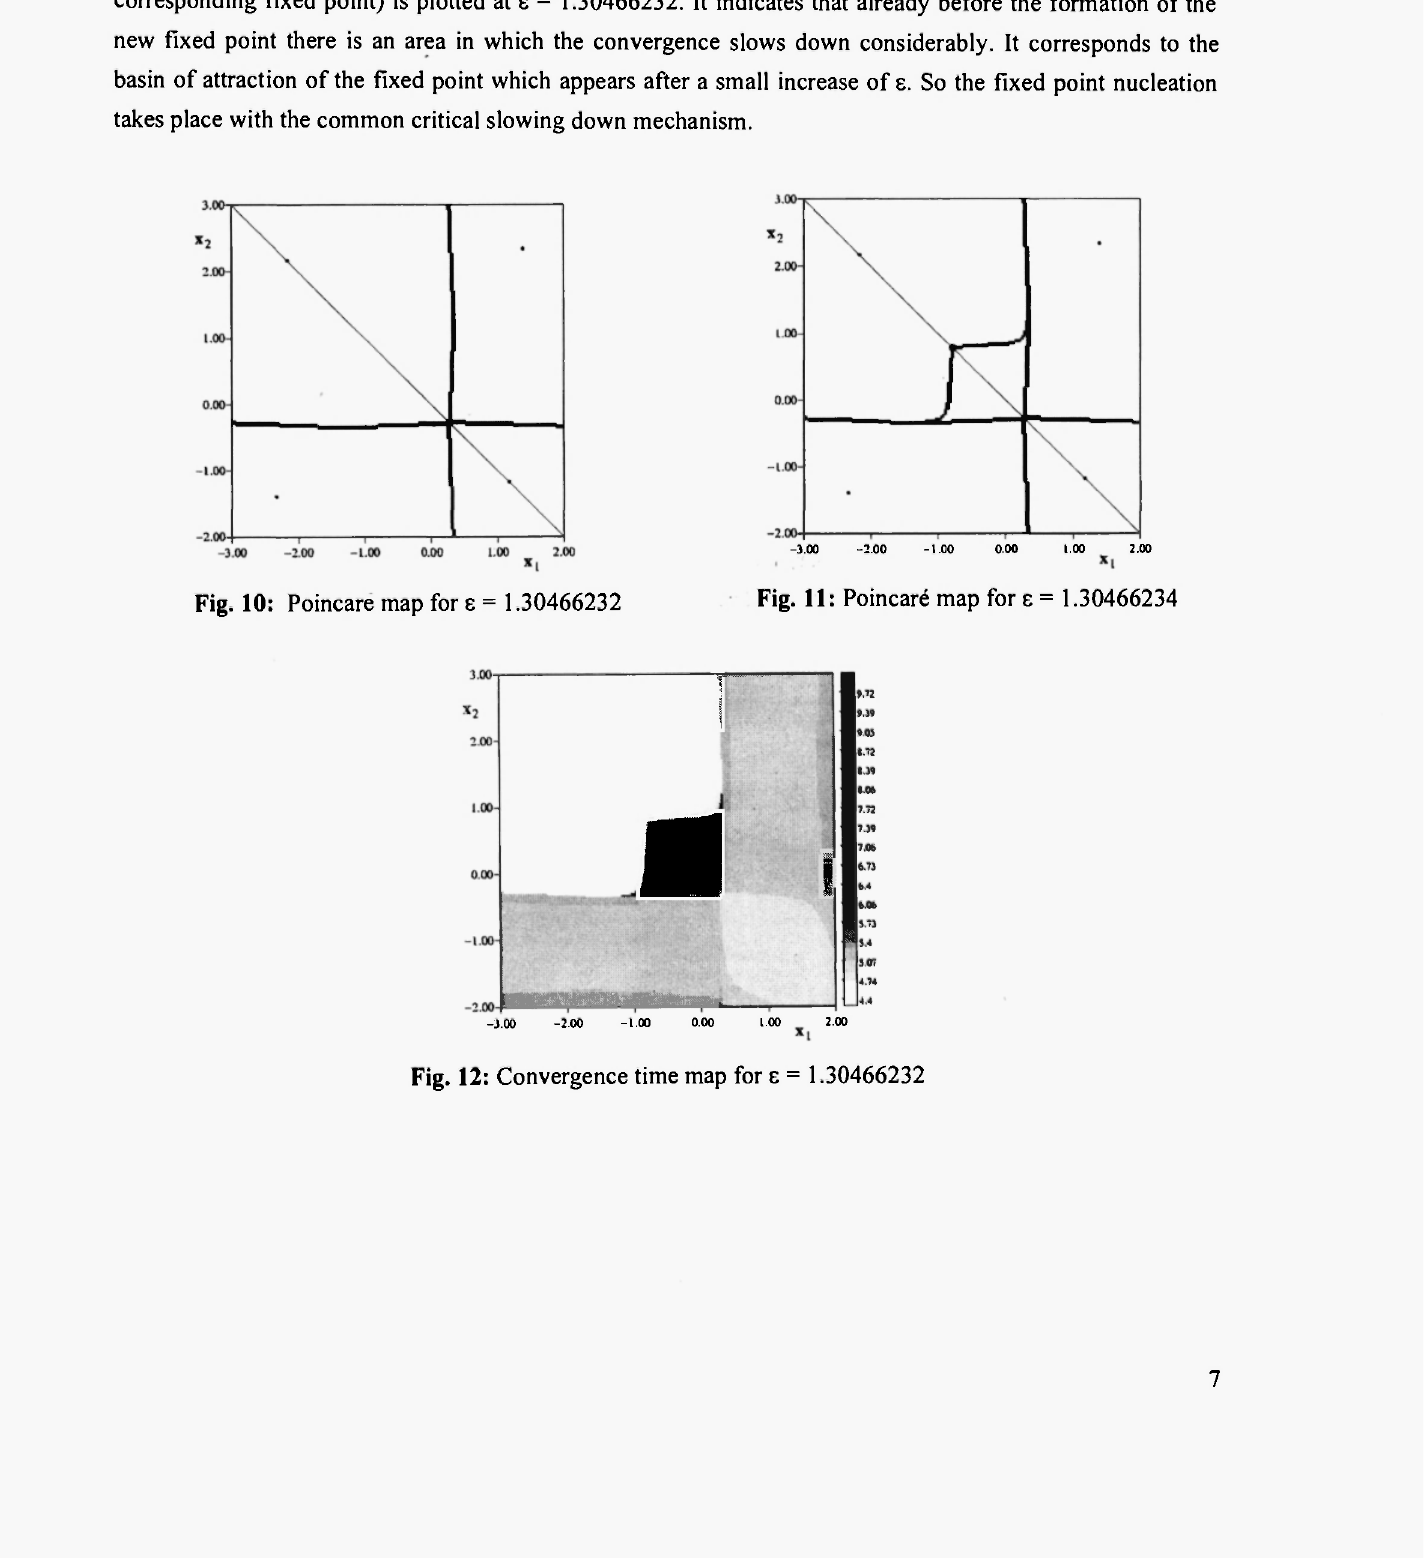
Fig. 12: Convergence time map for ε =